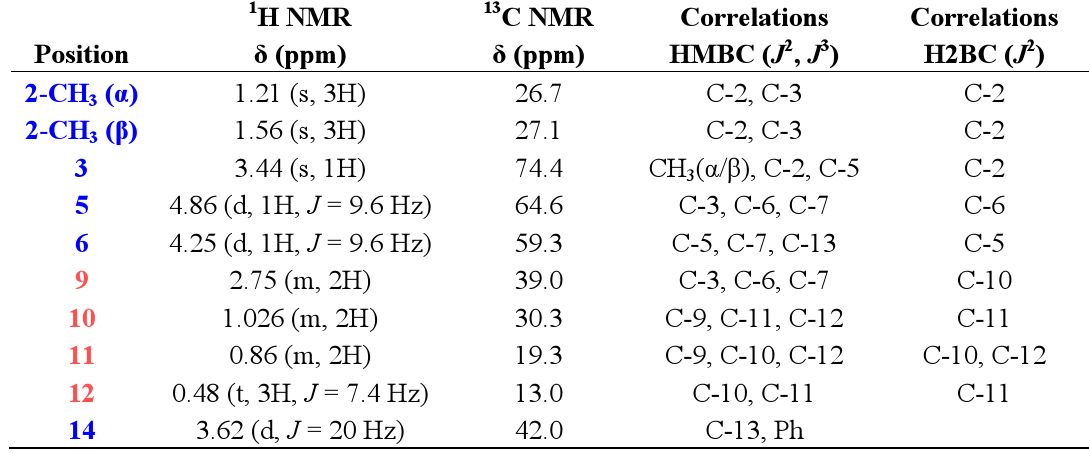
Table 1. Spectroscopic data assigned from HMQC, HMBC and H2BC spectra of Bu-BPO . 1 H NMR 13 C NMR Position δ (ppm)